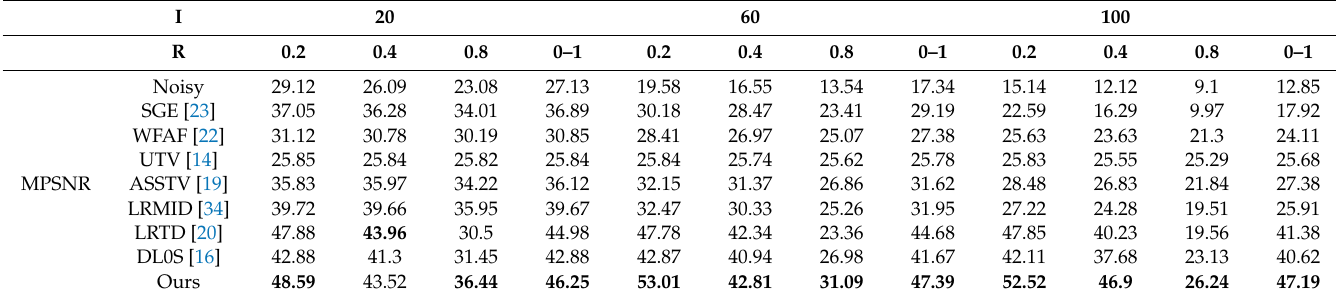
Table 2. The mean values of indices of WDCM with non-periodic